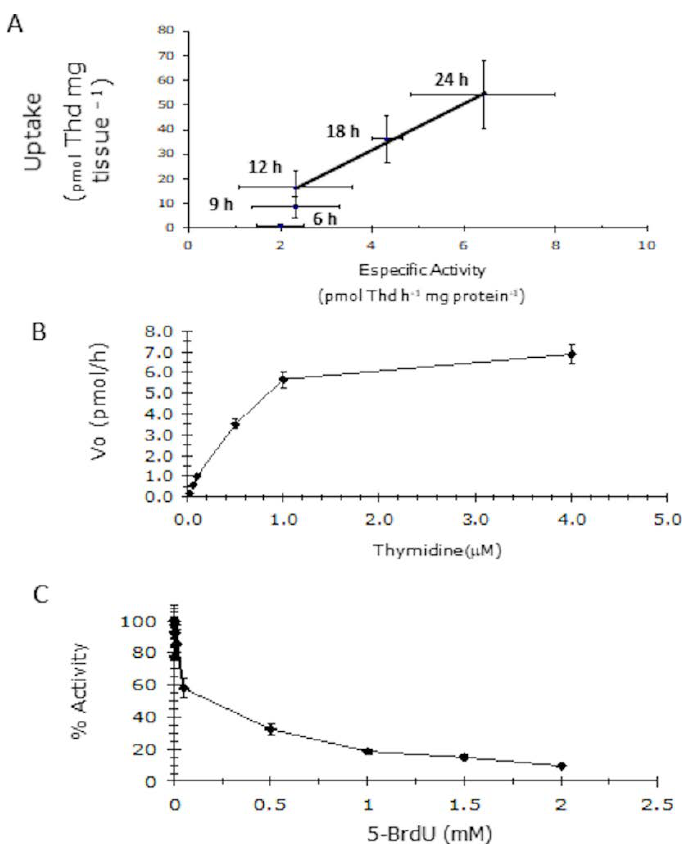
Figure 2. Biochemical characterization of maize thymidine kinase activity. ( A ) Association between TK enzymatic activity with DNA synthesis, assessed by 3 H-thymidine uptake, in maize embryo axes. ( B ) Michaelis–Menten plot of the TK activity for increasing thymidine concentrations. ( C ) Sensitivity of maize thymidine kinase activity to 5-bromo deoxyuridine. Values represent average ± standard deviation of three technical repeats from three independent protein extracts replicates.